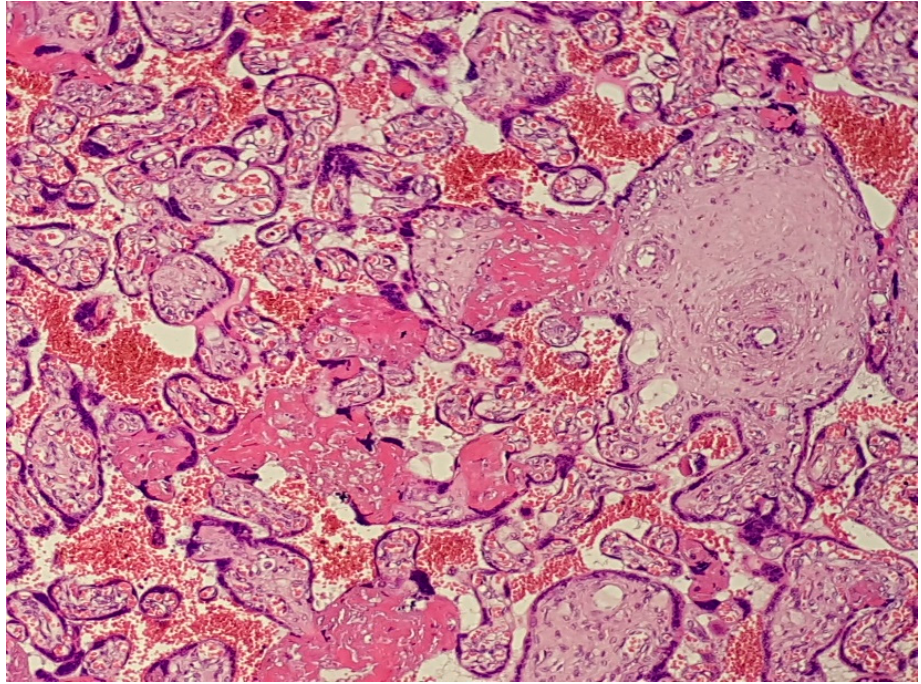
Figure 2. (Haematoxylin–eosin 10×). Features of accelerated maturation of the distal villi with numerous and prominent syncytial knots, fibrinoid deposits with incipient villous agglutination, and erosion of the syncytiotrophoblastic contour.